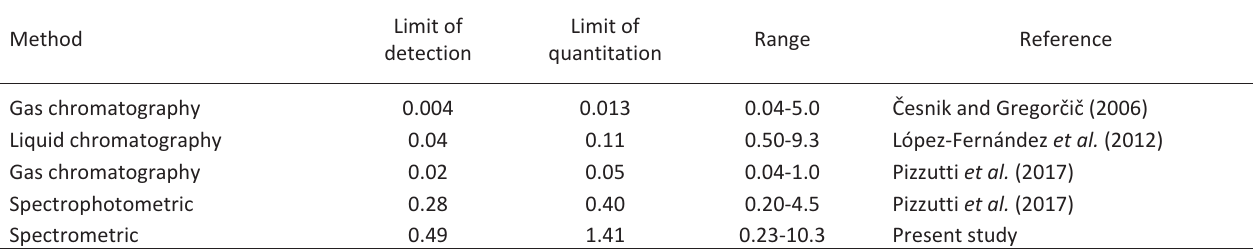
Table 2 ­ Limit of detection, limit of quantitation, and range (expressed in mg CS carbamates on